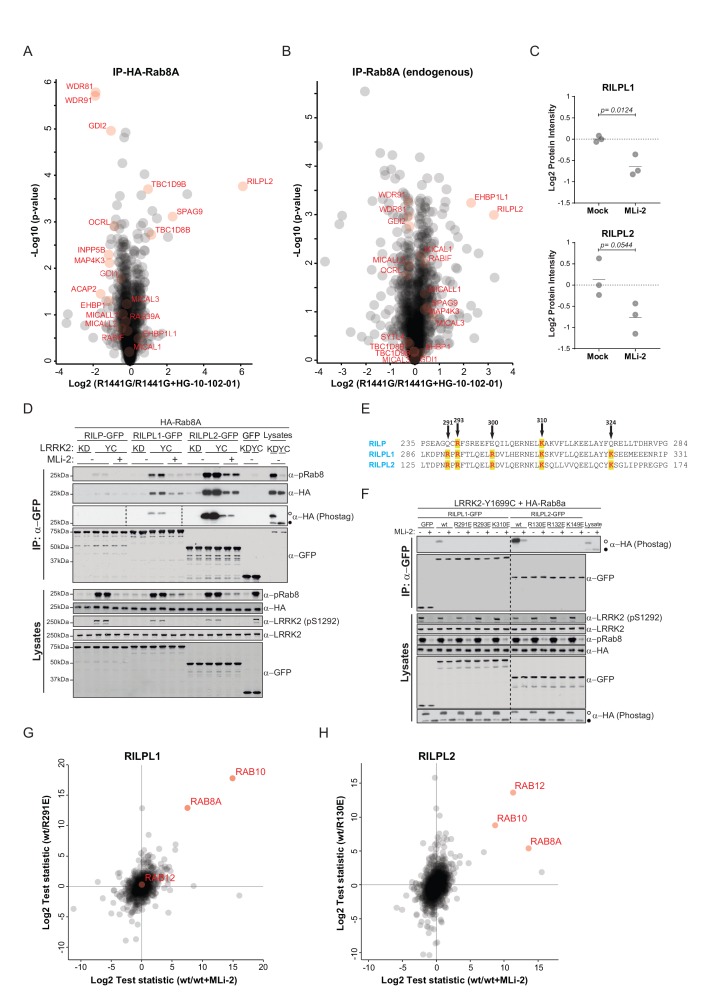
Phosphorylation-specific protein binding to Rabs.(A) AE-MS of HA-Rab8A and (B) endogenous Rab8A using extracts of GFP-LRRK2-R1441G expressing Flp-In T-Rex HEK293 cells. Expression of the kinase was induced for 48 hr by doxycycline (1 µg/ml) and LRRK2 inhibited using HG-10-102-01 (3 µM, 3 hr). LRRK2-regulated, known and unknown Rab8A-binding proteins in both AE-MS experiments are highlighted in red. (C) Label-free (LFQ [Cox et al., 2014]), MS-quantified RILPL1 and RILPL2 levels after immunoprecipitation of Rab8A from mock- or MLi-2 (200 nM, 2 hr) treated LRRK2-R1441C MEFs. (D) Pulldown of GFP-tagged RILP, RILPL1 or RILPL2, transiently expressed with HA-Rab8A and the indicated LRRK2 variants (KD= Y1699C/D2017A) in HEK293 cells. Western blot after Phos-tag SDS-PAGE was used to detect interacting proteins using the indicated antibodies. (MLi-2 = 150 nM, 2 hr). (E) Sequence alignment of the RILP homology (RH) domains of RILP, RILPL1 and RILPL2 showing five conserved basic residues, which are highlighted. (F) Same as (D) but using different RILPL1 and RILPL2 mutants. For phos-tag blots, filled circles indicate non phosphorylated proteins and open circles phosphorylated proteins. (G) AE-MS of GFP-RILPL1 (wt or R291E) and (H) GFP-RILPL2 (wt or R130E), expressed with LRRK2-Y1699C in HEK293 cells, and treated or not with MLi-2 (for wt, 200 nM, 2 hr). The student’s two sample test statistic (Log2) of the indicated comparisons was used for plotting.